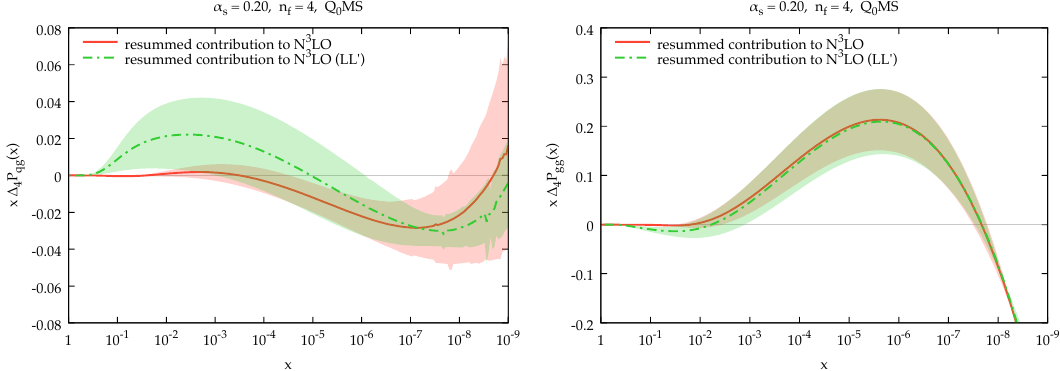
Figure 3 . Comparison between the resummed contributions (cid:1) 4 P qg (left) and (cid:1) 4 P gg (right) to be added to N 3 LO splitting functions (when available) in two variants of small- x